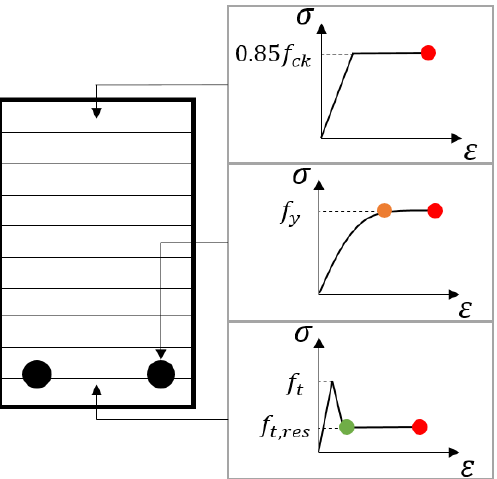
Figure 2. Identifying characteristic points of beam bending using the stresses and strains in fiber cross-sections. The collapse point is represented in red, yield point in orange and first-crack point in green for the case of a beam cross-section exposed to pure bending. The bottom side is in tension, and the top side is